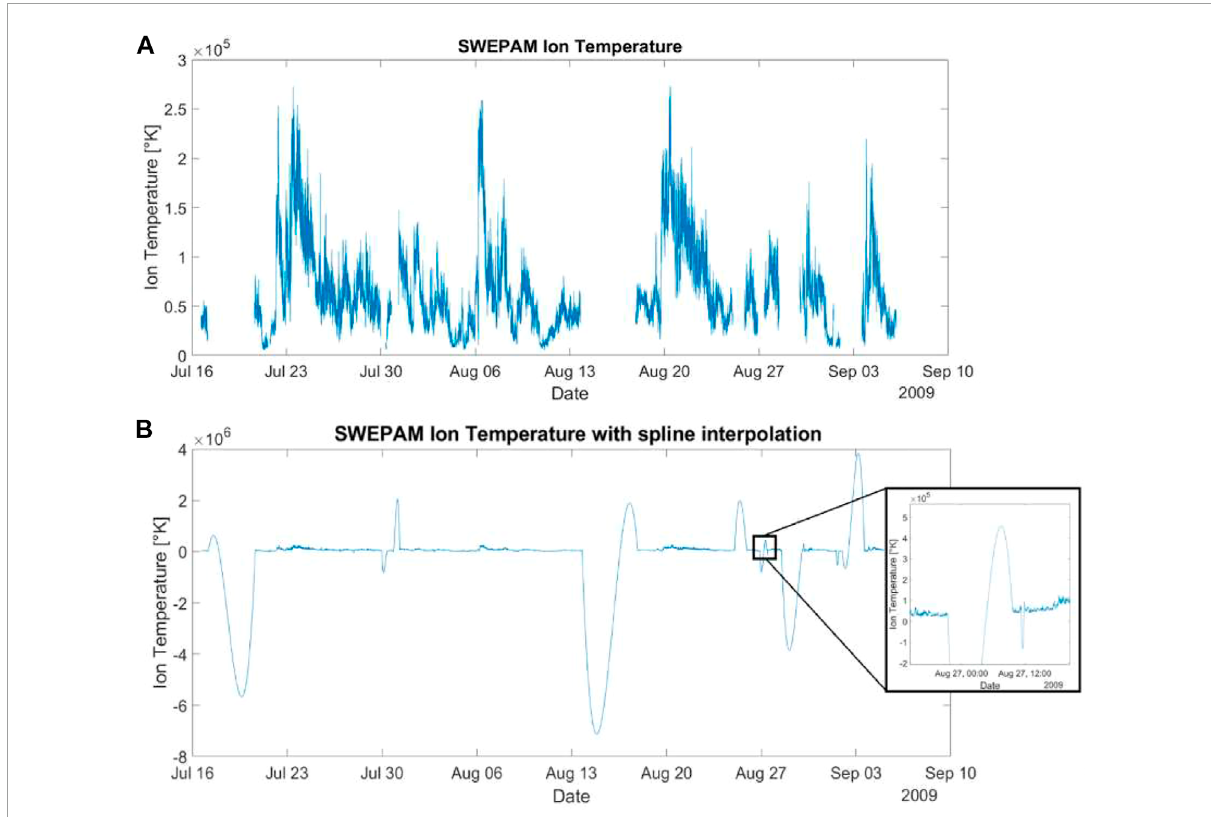
2009. Gaps seen in Figure 7A are now filled using a spline interpolation. On the right is a zoom on a particular period to highlight the large divergence caused by the